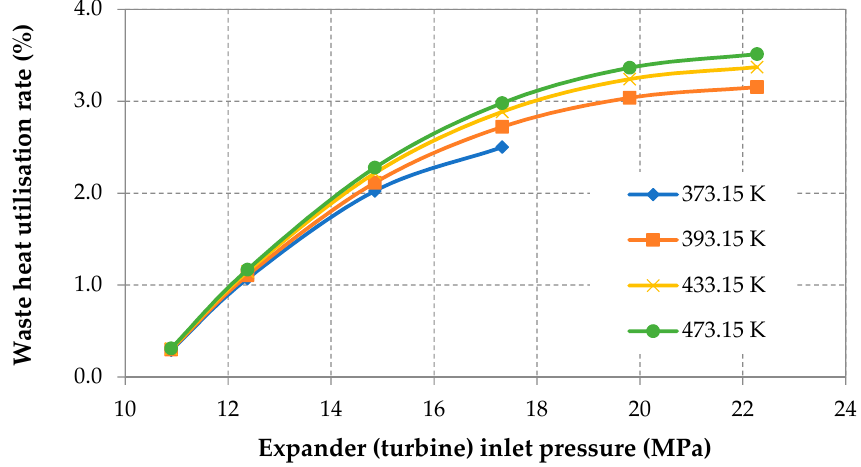
Figure 4. Relationship between turbine inlet temperature and waste heat utilization rate for the different exhaust gas temperature at the heat exchanger outlet.